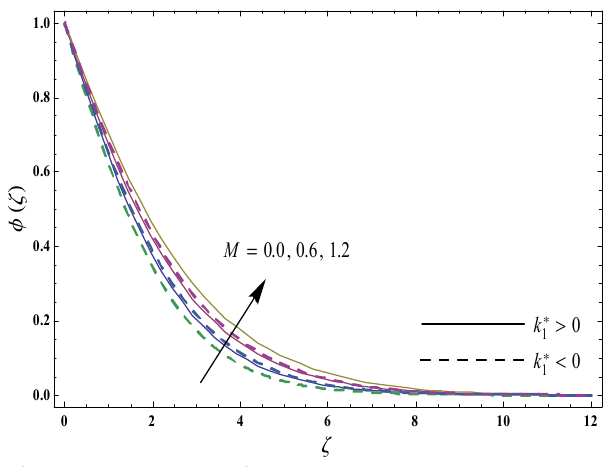
Figure 5. Variations of temperature for thermophoresis parameter when N b = 0.2, Sc = Pr = 1.0 and M = 0.2.